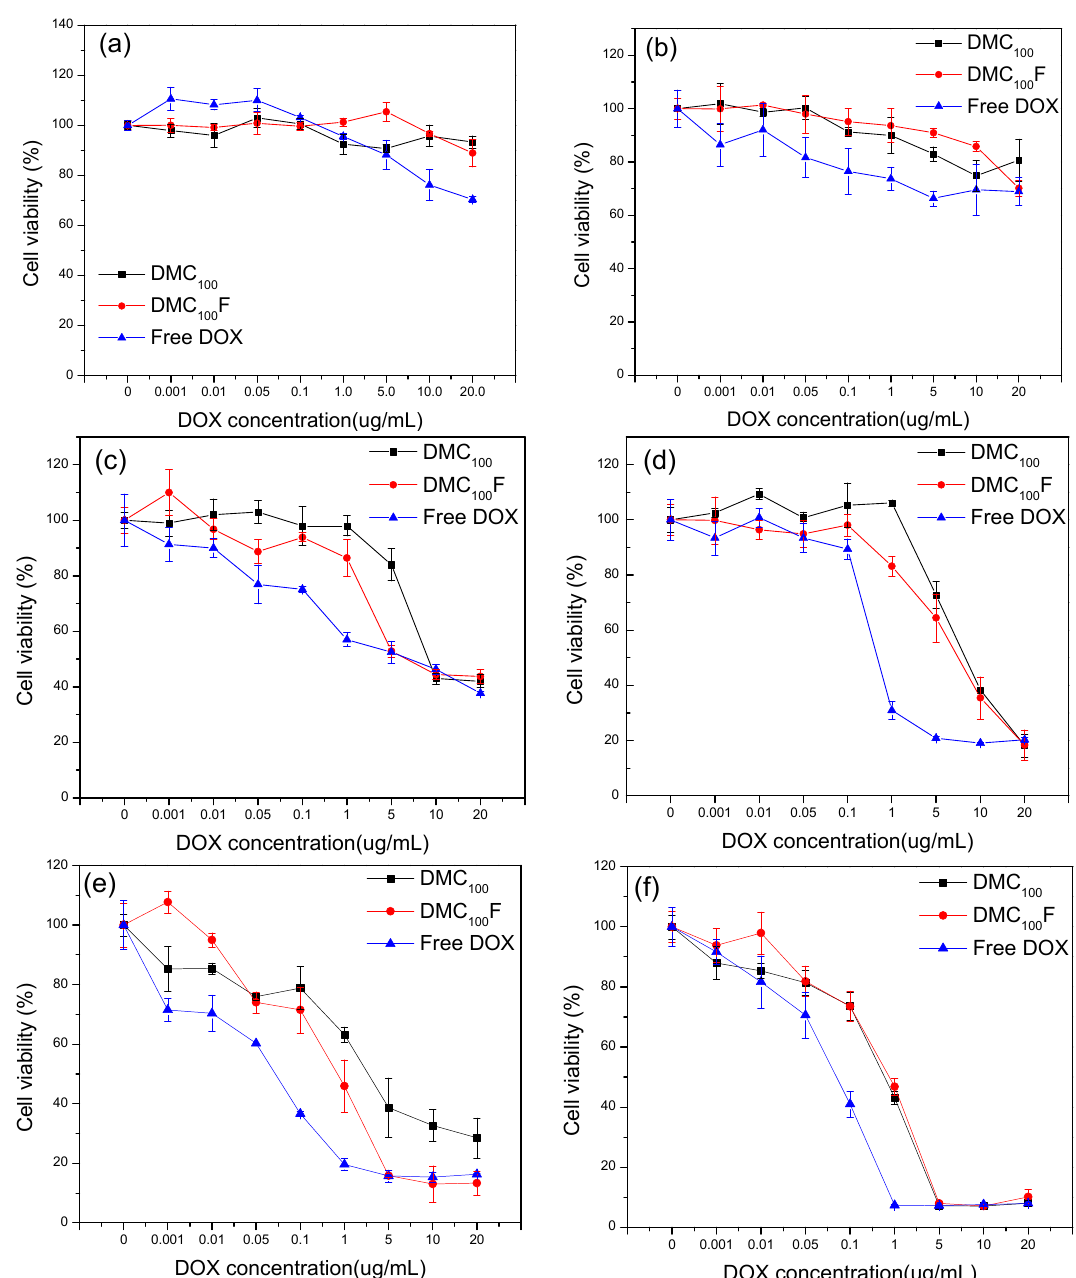
Figure 2. Cytotoxicities of human breast cancer cells (MCF-7)and human oral cavity carcinoma cells (KB) cells, when cells were incubated with DOX-loaded micelle (DMC F) and free DOX: MCF-7 cells: ( a ) 3 h; ( c ) 24 h; and ( e ) 48 h. KB cells: ( b ) 3 h; and DMC 100 ( d ) 24 h; and ( f ) 48